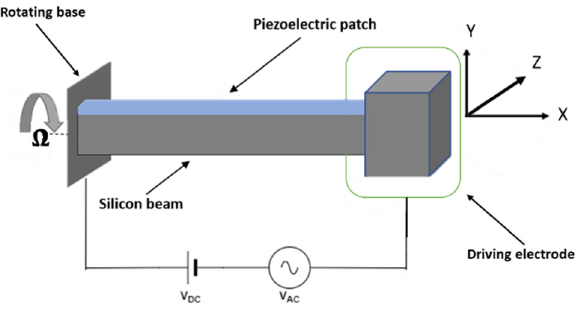
Figure 1. Schematics of gyroscope sensor with energy harvesting capabilities.